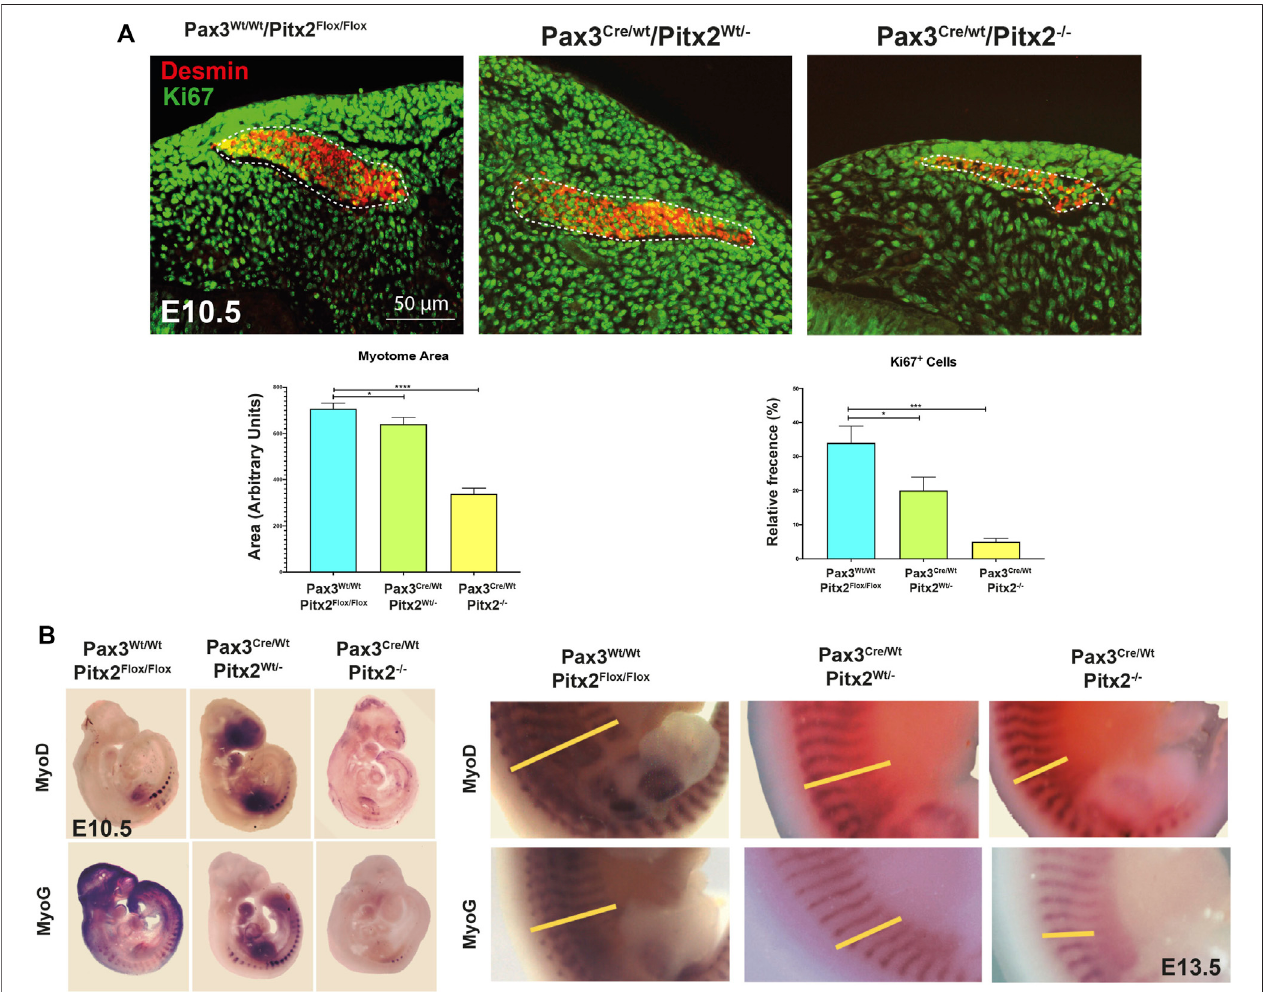
FIGURE 3 | The myotome area as well as the number of Ki67 + cells is reduced in Pax3 Cre/Wt /Pitx2 − / − conditional mutant embryos. (A) Representative images of DESMIN (dotted area) and KI67 co-immunostaining in the myotome of Pax3 Wt/Wt /Pitx2 Flox/Flox , Pax3 Cre/Wt /Pitx2 Wt/- and Pax3 Cre/Wt /Pitx2 − / − mice at E10.5 stage. Quanti fi cation of Ki67 + cells in the myotome is shown. (B) Representative images of in situ hybridization for Myod1 and Myogenin ( MyoG ) in Pax3 Wt/Wt /Pitx2 Flox/Flox , Pax3 Cre/Wt /Pitx2 Wt/ − and Pax3 Cre/Wt /Pitx2 − / − embryos at E10.5 and E13.5 stages. Note that Myod1 and Myogenin staining at E13.5 are delineated by yellow bars. * p < 0.1, *** p < 0.001 ( n = at least 3 embryos per condition).